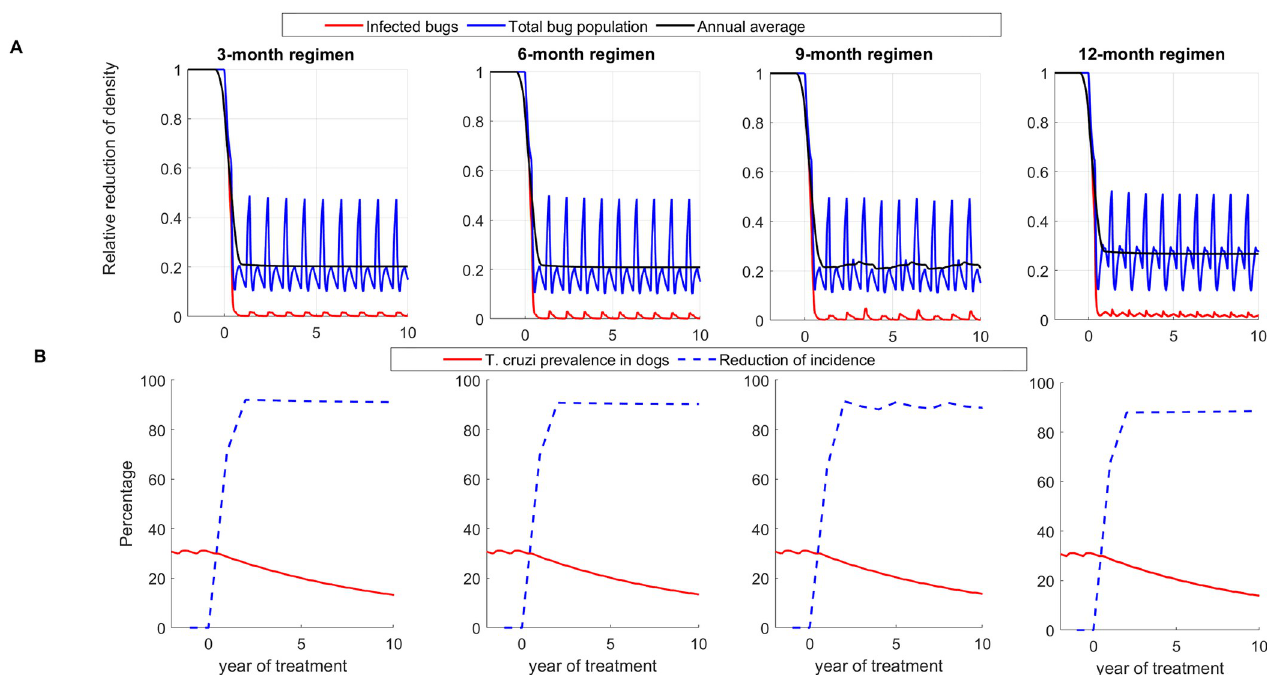
Fig 7. Effectiveness of systemic insecticide treatment of dogs with fluralaner for the control of canine Chagas in a high transmission setting with 3-month, 6-month, 9-month, and 12-month treatment regimens using Model 3. (A) Reduction of total population density (blue) and T . cruzi infections in triatomines (red), (B) Reduction of T . cruzi infection prevalence (red) and incidence in dogs (blue). Effectiveness is evaluated using the spatially coupled model.